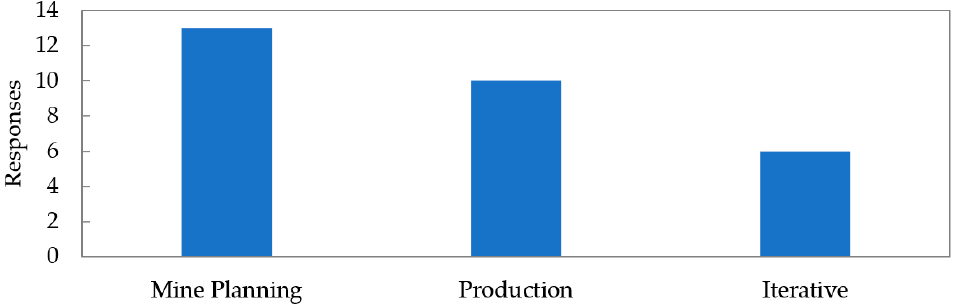
Figure 7. Mining stage at which the stope design process takes place. The iterative stage means the stope design takes place in multiple stages with a feedback loop.